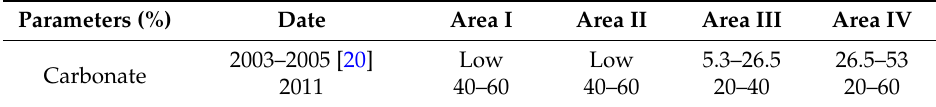
Table 5. Changes in organic matter and carbonate distribution in the seabed sediment after lagoon management